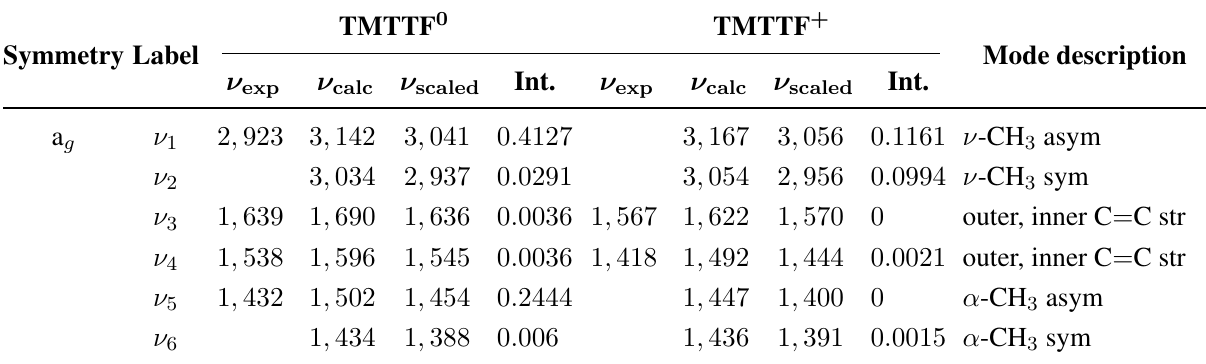
Figure A2. The following abbreviations are used: Int.: Intensity, asym: asymmetric, sym: symmetric, def: deformation, ip: in-plane, oop: out-of-plane, tor: torsion, str: stretching, brea: breathing, bend: bending. TMTTF 0 TMTTF